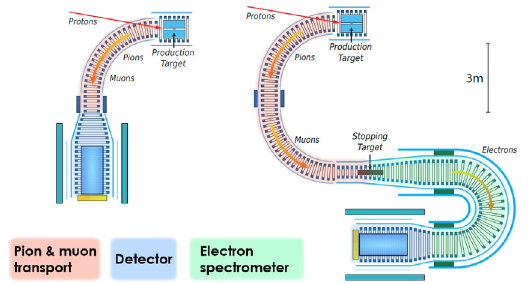
Figure 2. Plan view of Phase-I [left] and Phase-II [right] of COMET. The Capture section and first 90 ◦ are common to both Phases.